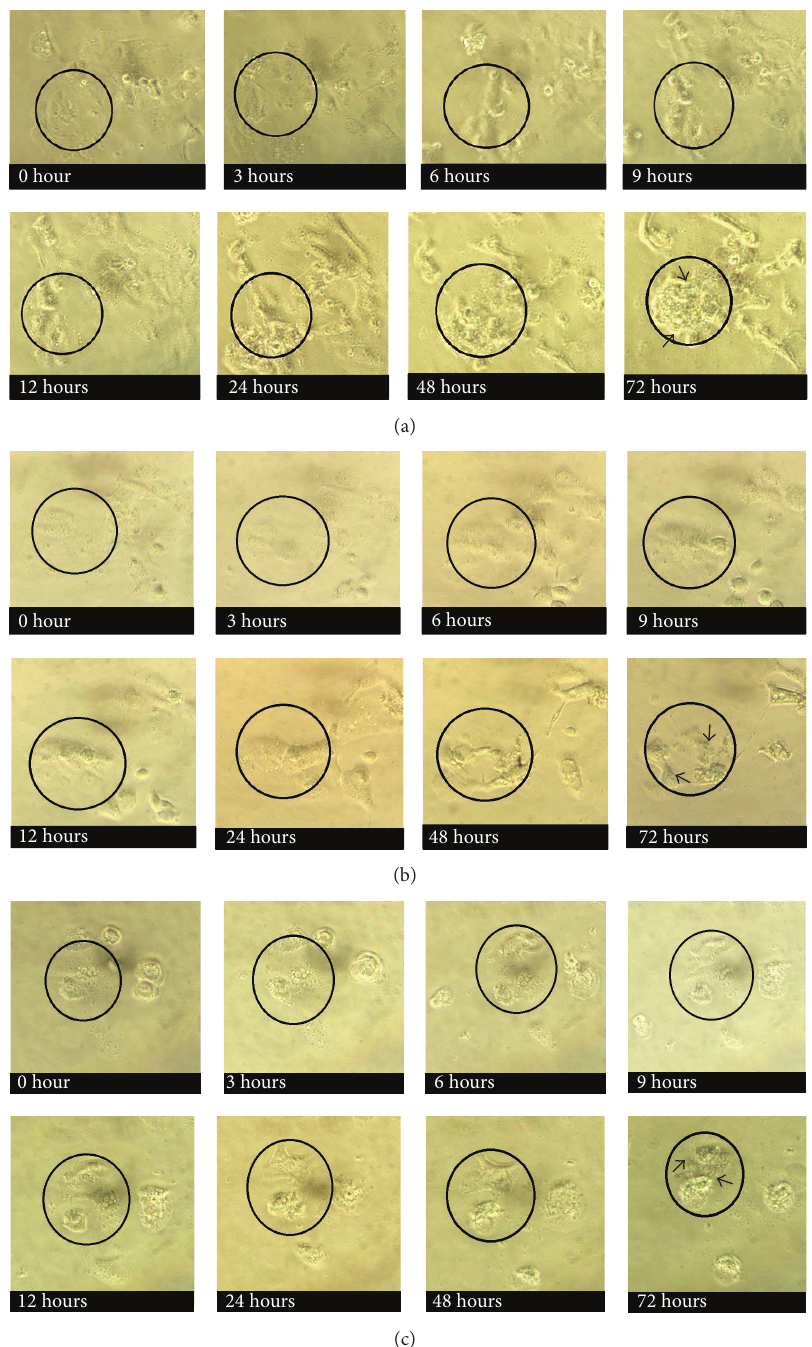
Figure 2: Responses of ORL-48 cells to 100 𝜇 g/mL extract of (a) Brucea sp., (b) Azadirachta sp., and (c) Typhonium sp. monitored from 0hr to 72 hr following treatment. Sign of cell attrition was focused on cells within the black circles. The arrow heads pointed the apoptotic cells. Images were obtained using an inverted microscope.